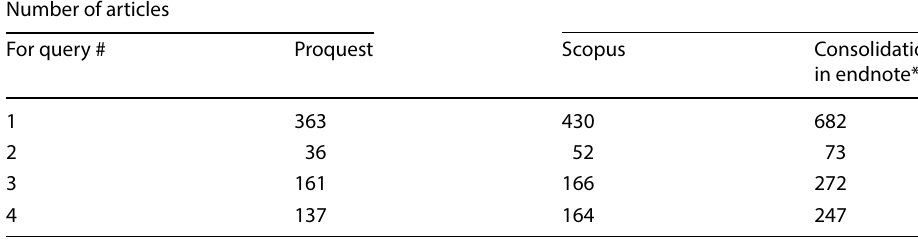
Table 2 Database Query Results